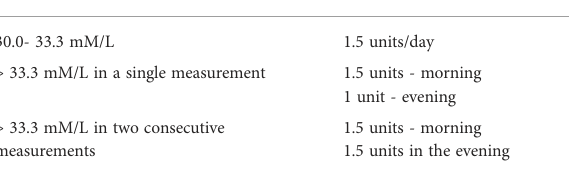
TABLE 1 Dosing and administration of